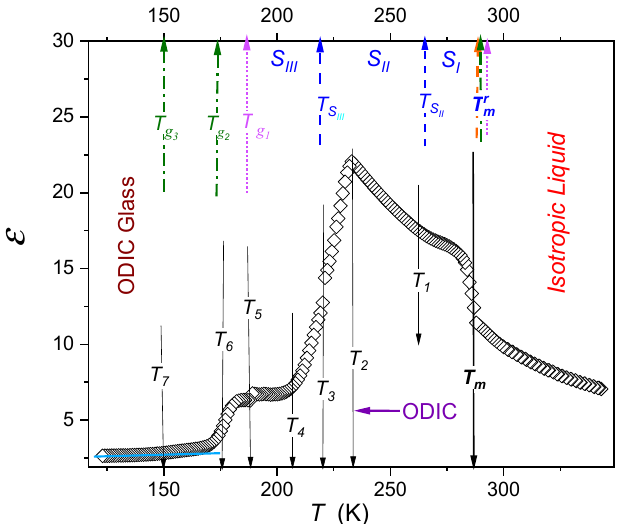
Figure 3. Temperature evolution of the dielectric constant in ODIC-forming cyclooctanol. Solid arrows pointing downwards show characteristic temperatures extracted from our measurements: T m = 286.4 K, T 1 = 233 K, T 2 = 207.1 K, T 3 = 178.2 K. Arrows pointing upwards are related to previously published values of relevant critical temperatures: (i) blue, dashed: from the work in [7], (ii) dotted, pink: from the work in [7], and (iii) dot-dashed, green: from the work in [8].